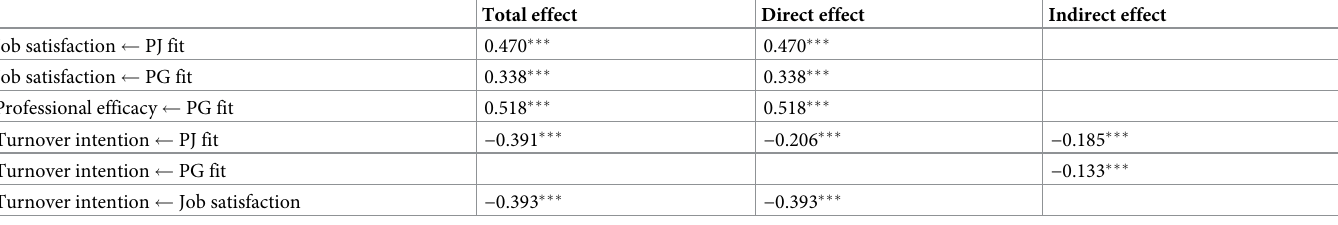
Table 4. Path decomposition of effects in structural equation